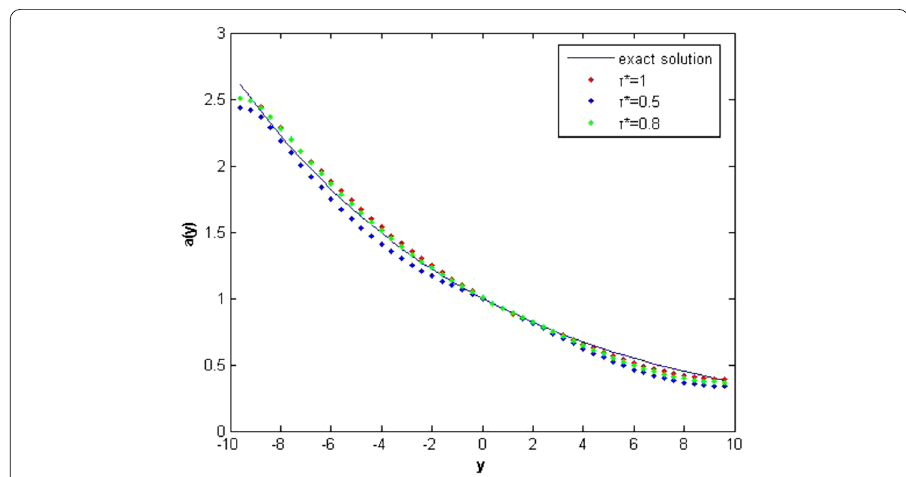
Figure 5 Identified drifts with the noisy level 0.001 for Example 3